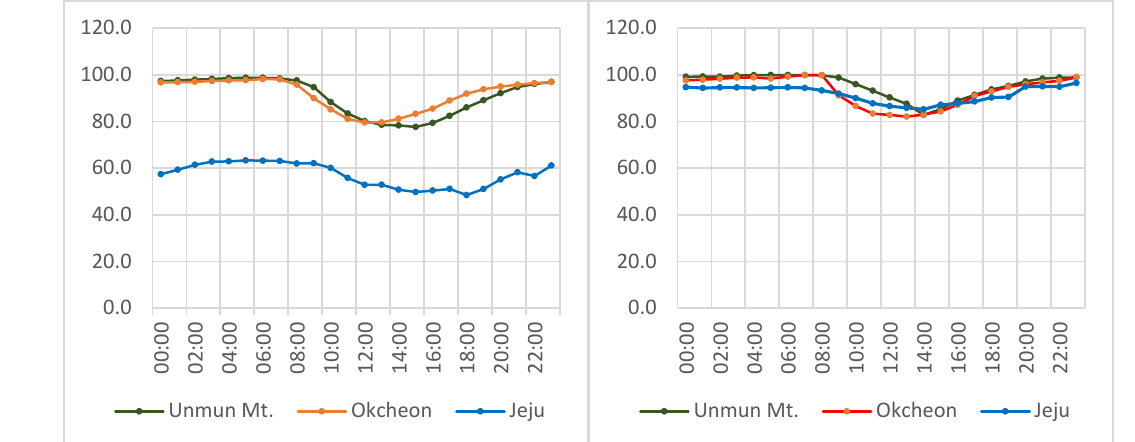
Figure 5. Daily mean atmospheric humidity in June ( left ) and July ( right ), 2014.